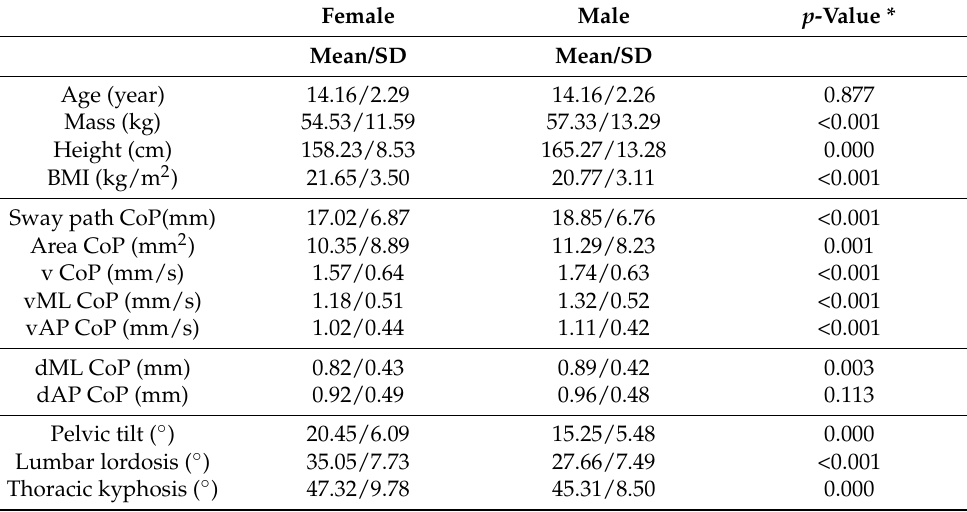
Table 1. Sample characterization, stabilometric and angular variables, separated by gender. Compari- son between genders for all